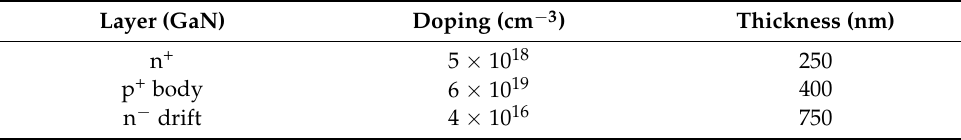
Table 1. Structural properties of the vertical GaN-on-Si diodes under test.